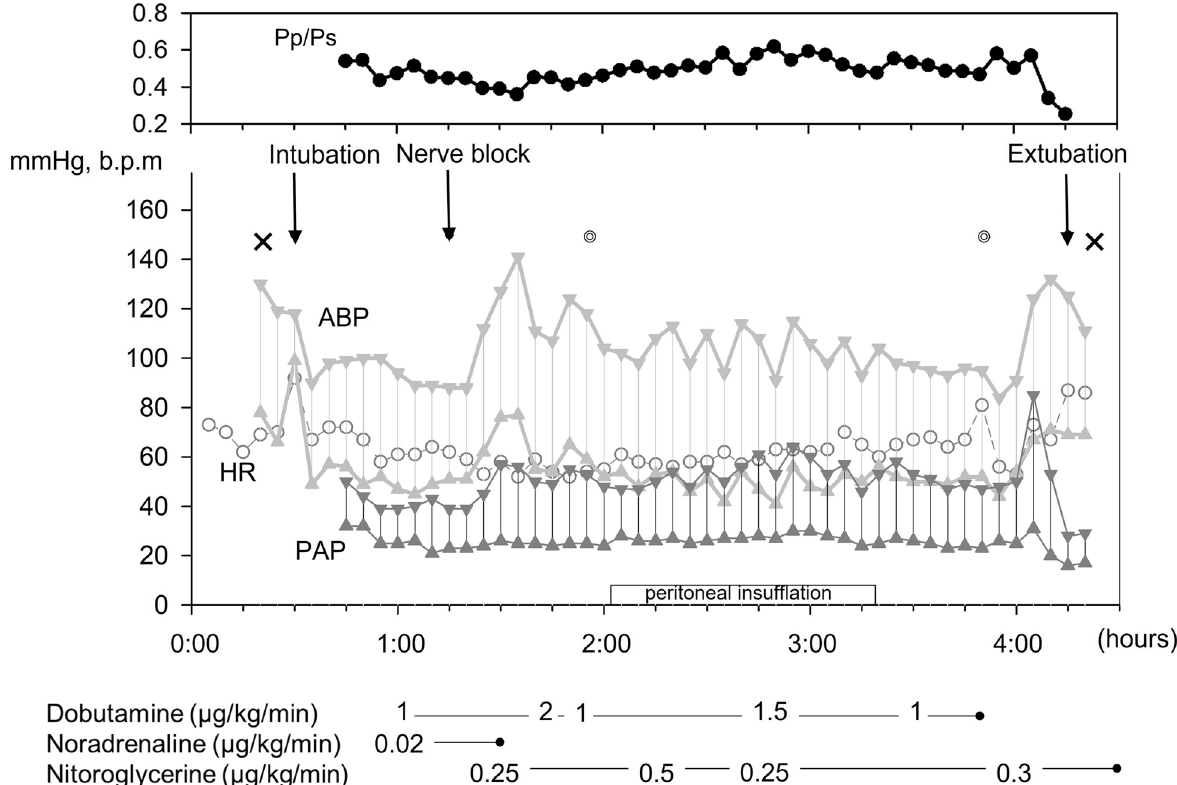
Fig. 1 Anesthesia record. The ratio of mean pulmonary artery pressure to mean artery pressure (Pp/Ps) was increased from 0.36 to 0.58 after peritoneal insufflation, requiring an increase in the infusion rate of nitroglycerine. X: start and end of anesthesia; ◎ : start and end of the operation. ABP, arterial blood pressure; HR, heart rate; PAP, pulmonary arterial pressure; Pp/Ps, the ratio of mean pulmonary artery pressure to mean artery